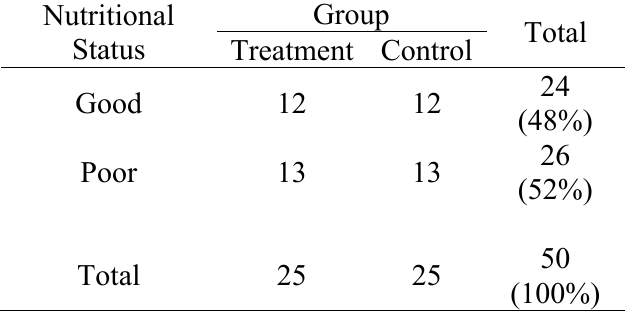
Table 2. Characteristic of samples based on nutritional status Nutritional